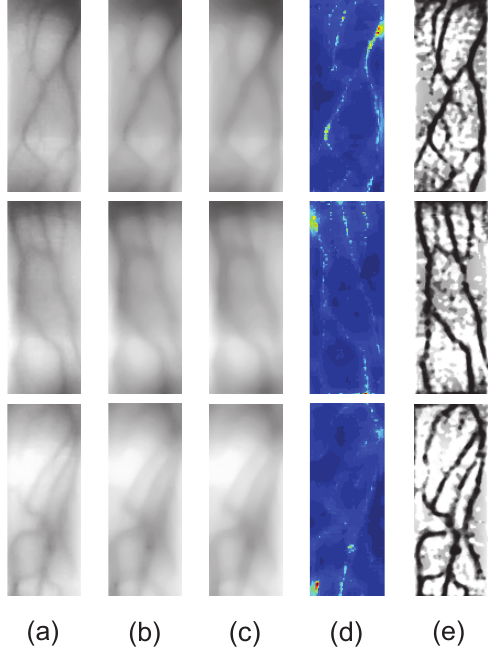
Figure 9. Scattering removal experiments. ( a ) Some captured finger-vein images I ( x; y ) . ( b ) The estimated scattering components V ( x; y ) . ( c ) The estimated scattering